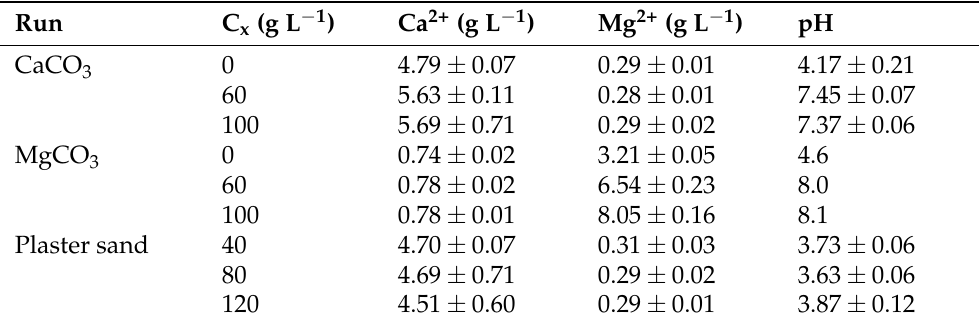
Table 1. Inductively coupled plasma (ICP) measurements of Ca 2+ and Mg 2+ at the end of each production phase (198 h), in comparison to the baseline